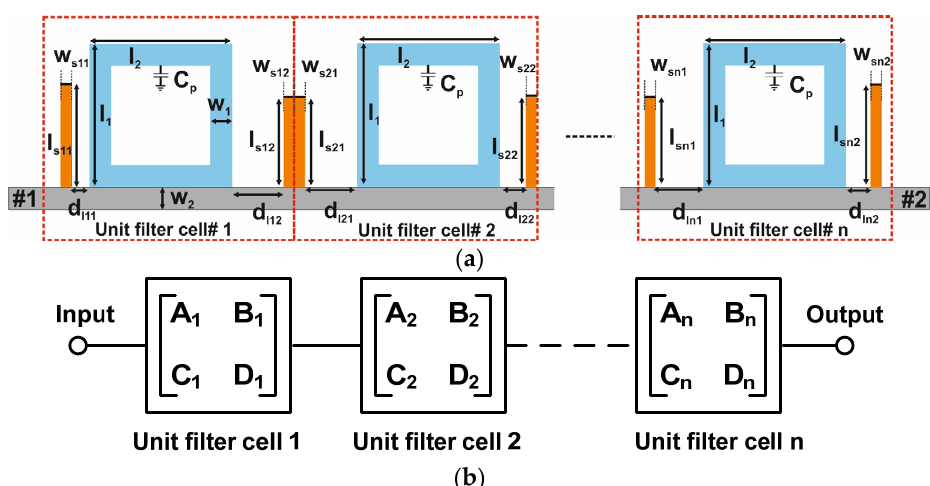
Figure 10. ( a ) General configuration, ( b ) Schematic diagram of the TBFSLR.